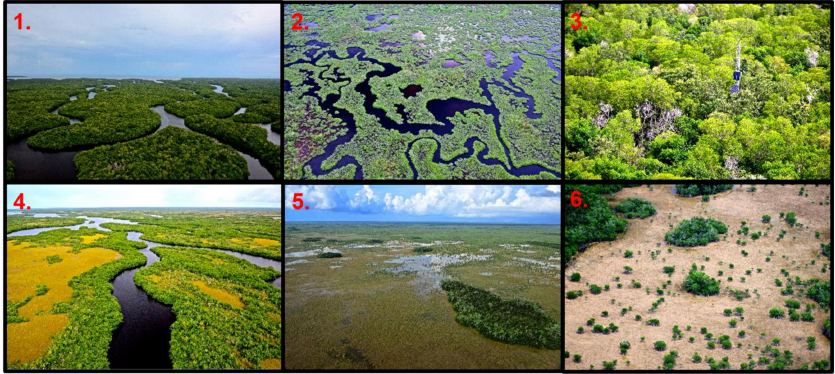
Figure 4. Example of geotagged photography acquired inside the Everglades National Park boundaries. ( 1. ) Mangroves at the mouth of SRS; ( 2. ) Short mangroves; ( 3. ) Tall mangroves in SRS-6 site; ( 4. ) Short mangroves and sawgrass located at the Northwestern region of SRS; ( 5. ) Tree islands and mangroves near the boundary of the mangrove transition zone; ( 6. ) Mixture of tree islands and short